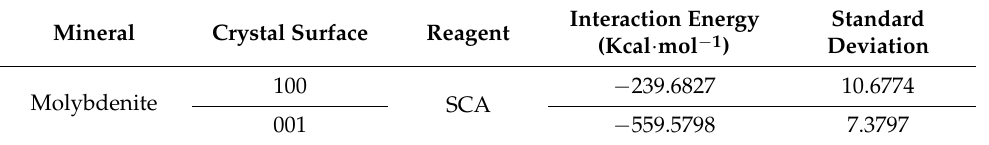
Table 2. The interaction energy of SCA with the